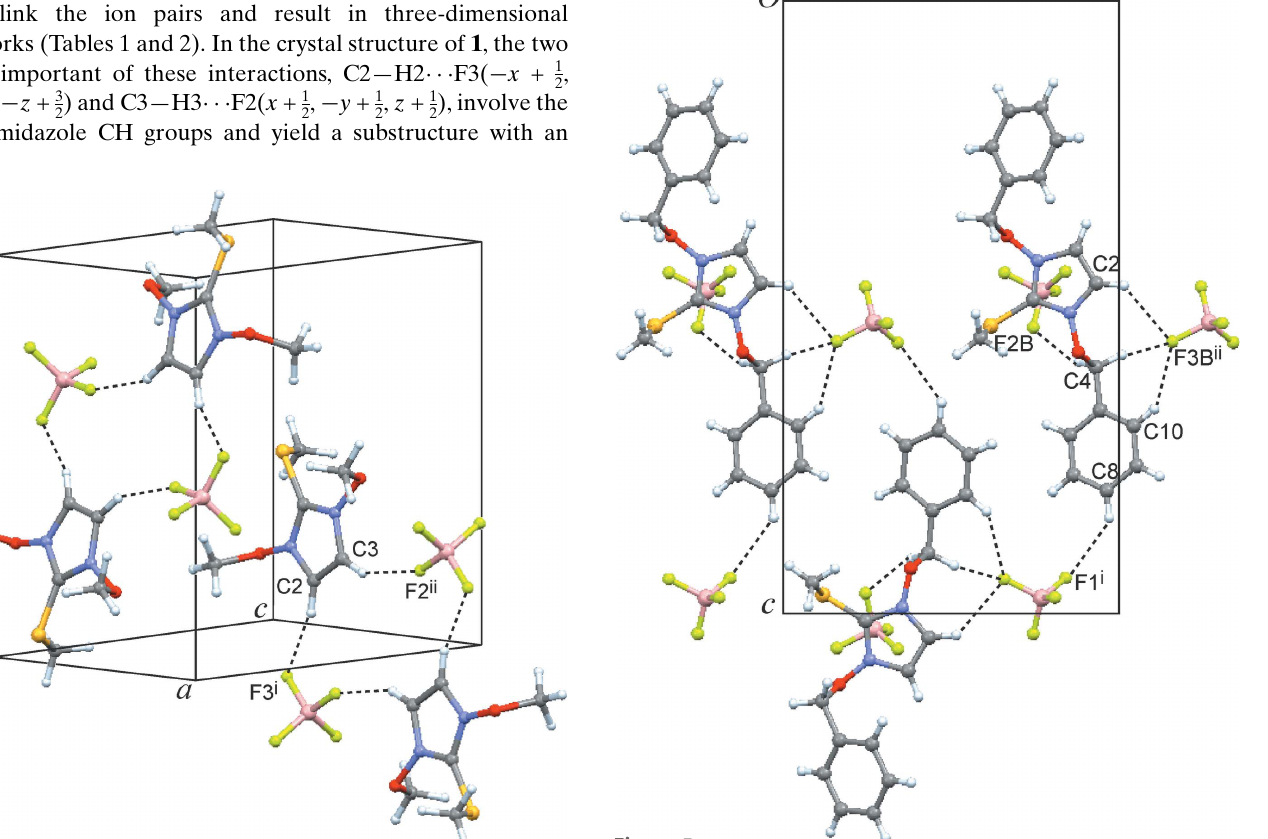
Figure 5 Crystal packing of compound 2 , viewed along the a axis. Dashed lines represent the shortest intermolecular C—H (cid:2)(cid:2)(cid:2) F interactions involving the disorder component B of the tetrafluoridoborate anion. [Symmetry codes: (i) (cid:3) x + 1, y , z + 1